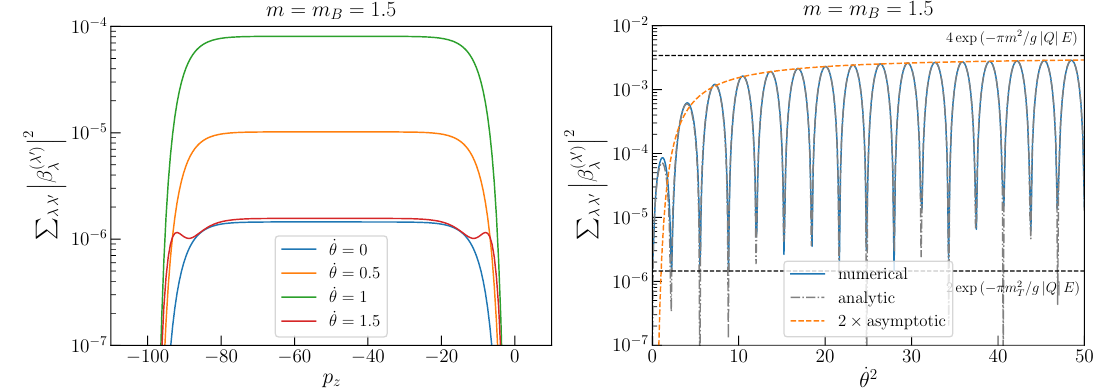
(cid:12) (cid:12) 2 0 ) (cid:12) (cid:12) β ( λ as a function of p z for several different values of (cid:12) (cid:12) λλ 0 λ ˙ θ . z = − 50 as a function of